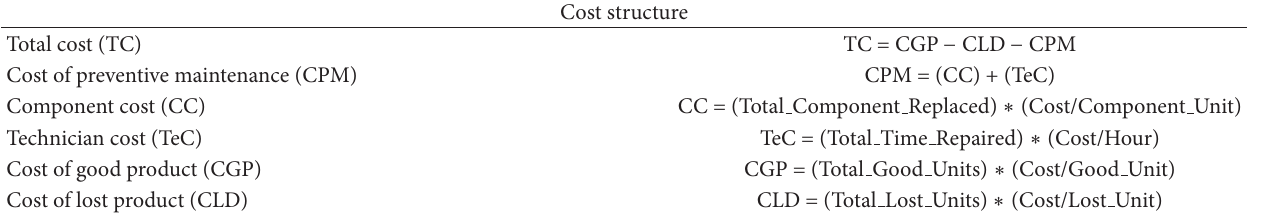
Table 8: Cost structure for performance measures.